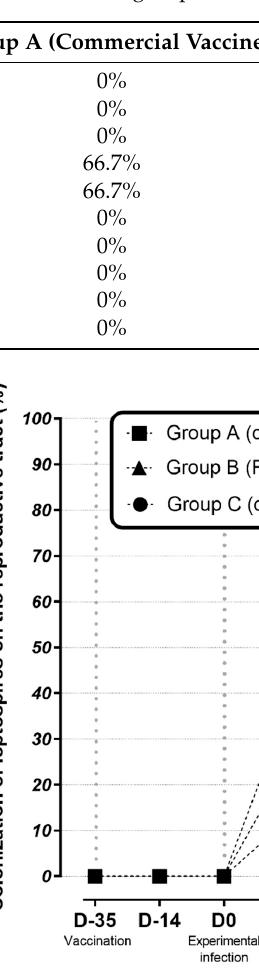
Table 2. Percentage of positive sheep in urinary PCR in non-vaccinated (control) and vaccinated groups between D-35 (first vaccine dose) and D210 post-infection. * p < 0.05 between vaccinated and non-vaccinated groups.